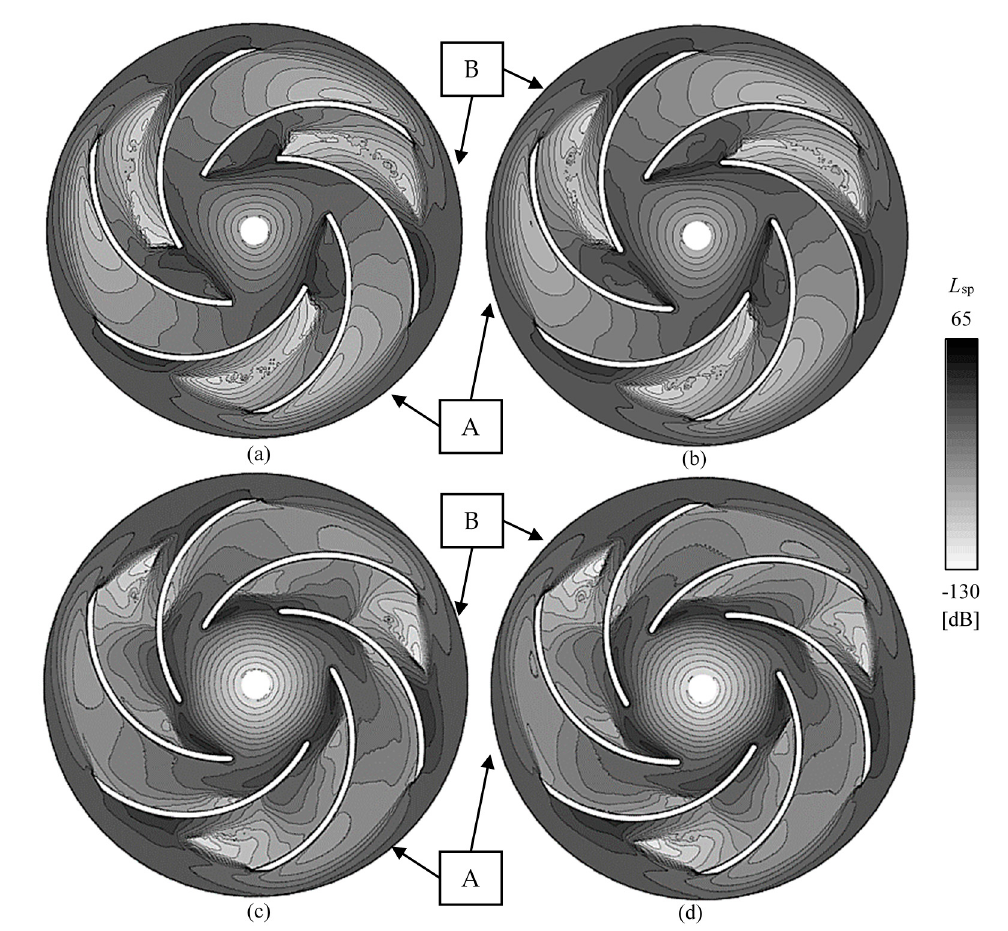
Figure 13. Contour of the sound power level, L sp : ( a ) blunt, ( b ) sharp, ( c ) round, and ( d ) ellipse.